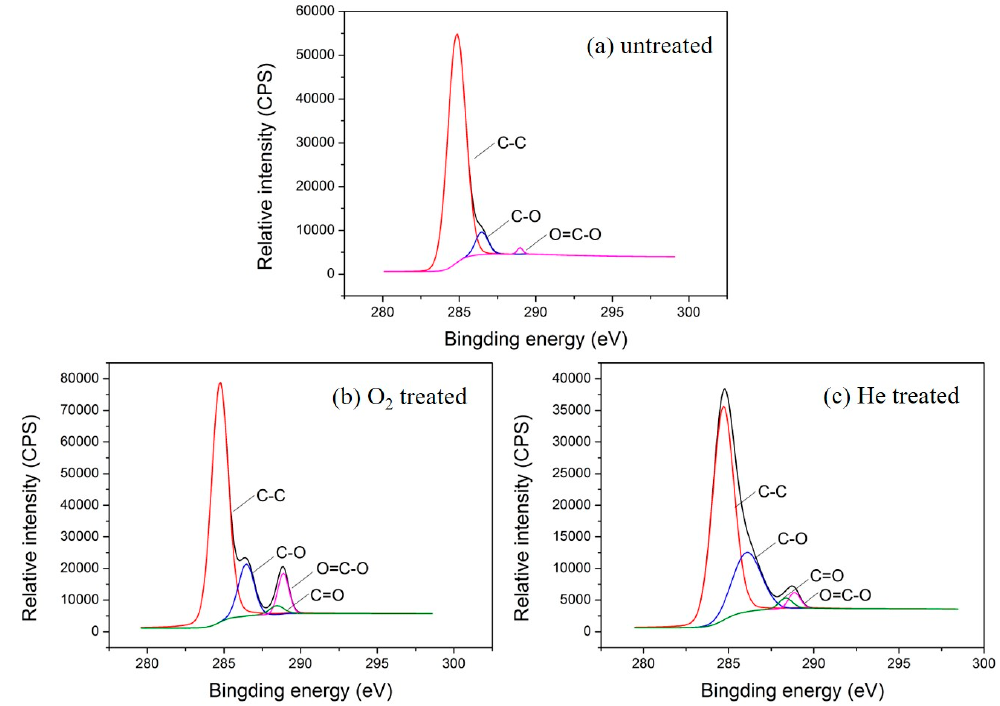
Figure7. C1sspectraofthe( a )untreated, ( b )oxygen, and( c )heliumplasma-treatedtextilepilematerials. Figure 7. C 1s spectra of the ( a ) untreated, ( b ) oxygen, and ( c ) helium plasma-treated textile pile materials. Table 3. Functional group percentage before and after plasma Table 3. Functional group percentage before and after plasma treatments.